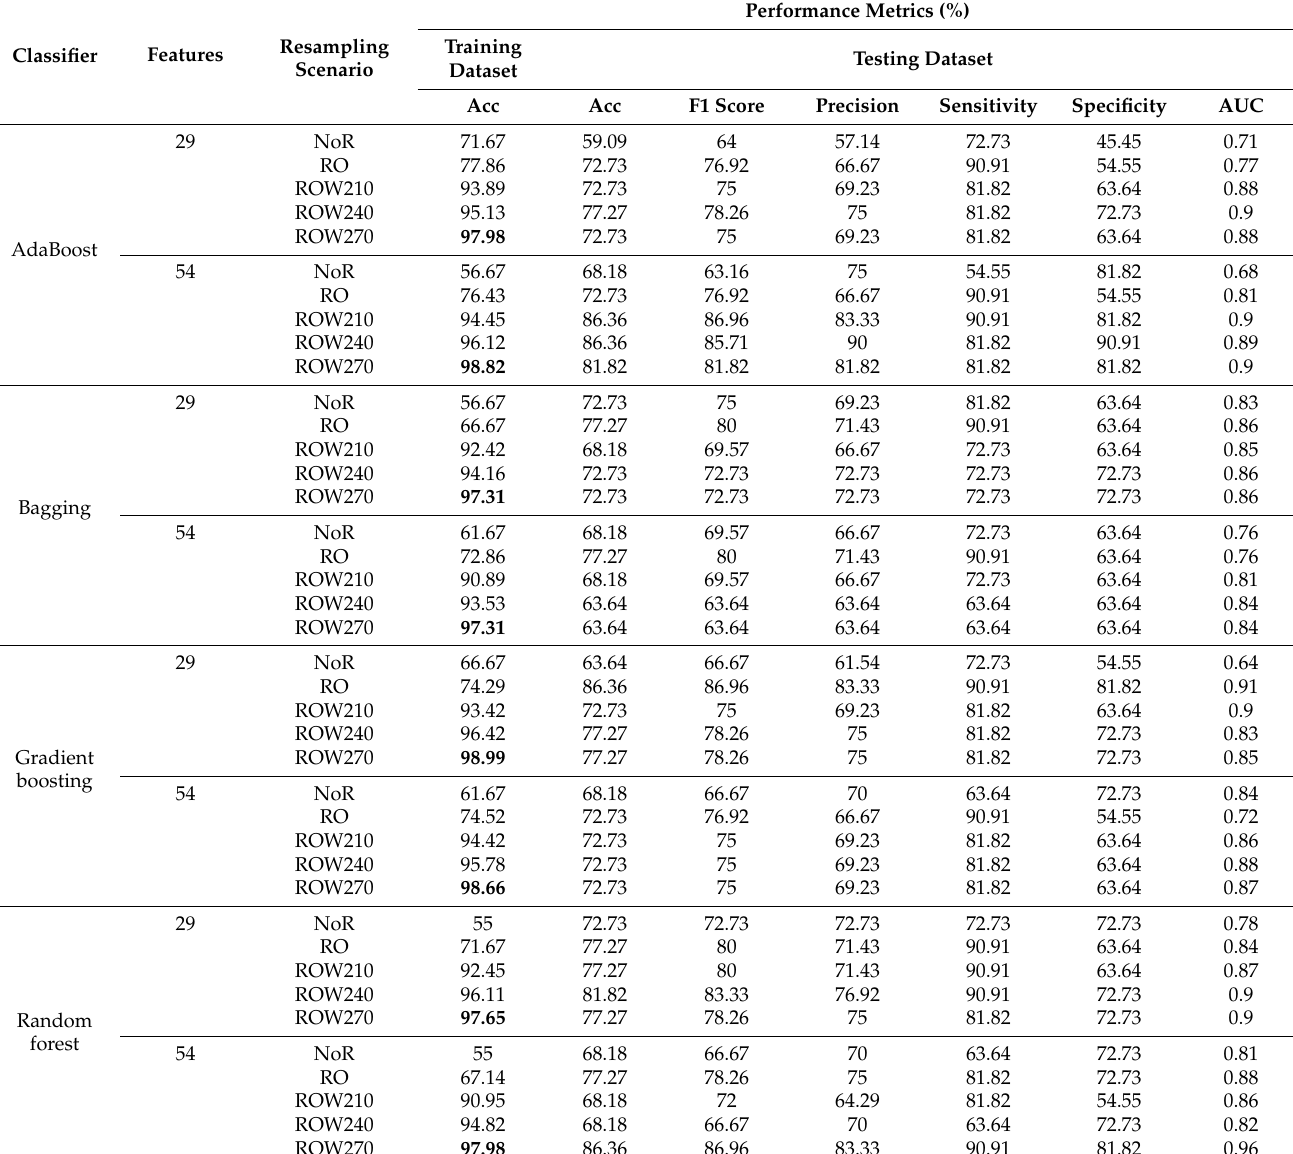
Table 9. Summary of performance metrics using all windows in the training dataset and testing dataset for all 5 resampling scenarios with 29 and 54 features applied to the 4 classification models. In each classifier with different features and resampling scenarios, the best result in terms of accuracy of the training dataset is shown in